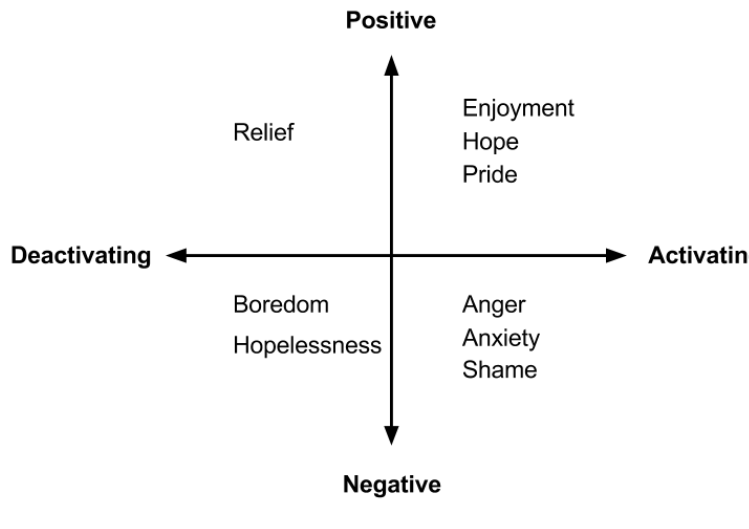
Figure 1. Taxonomy of achievement emotions into four